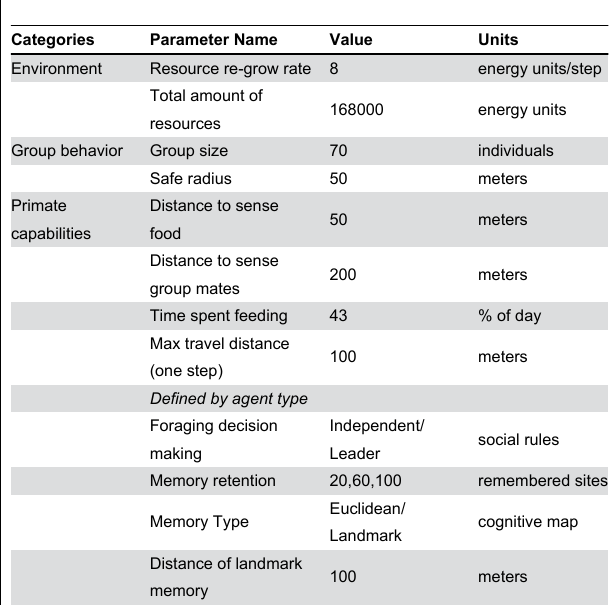
Table 1. Model parameters describing landscape and primate